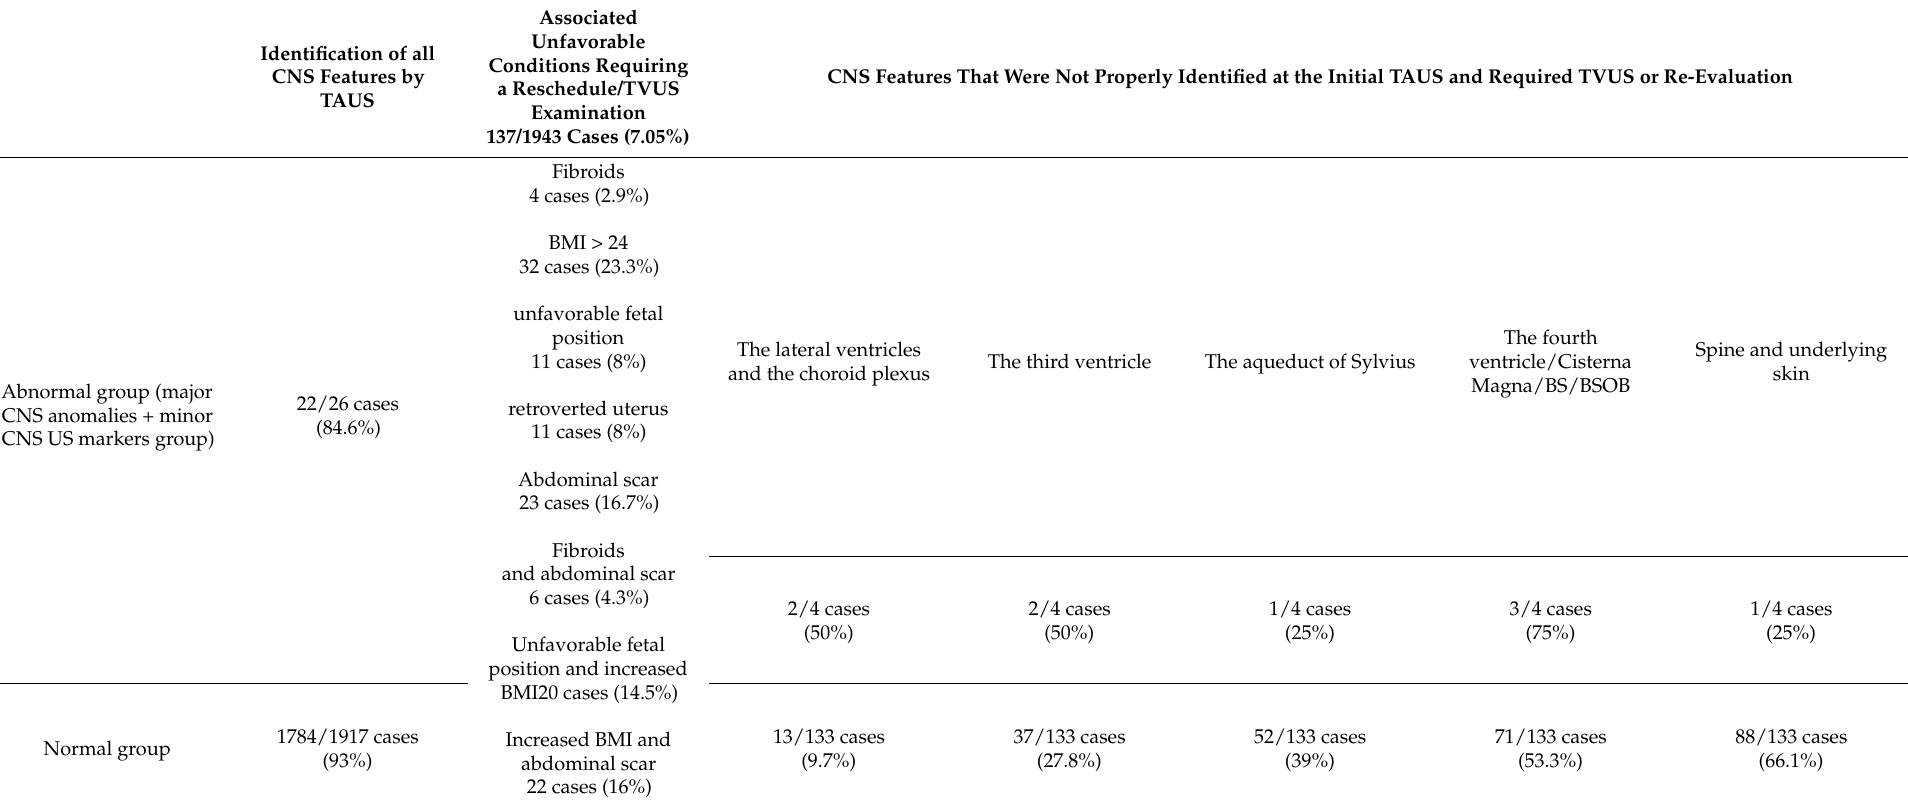
Table 1. The comparative satisfactory evaluation rate of the CNS features in the abnormal and normal group, reasons for not-satisfactory visualization by TAUS and the results after a reschedule and/or a